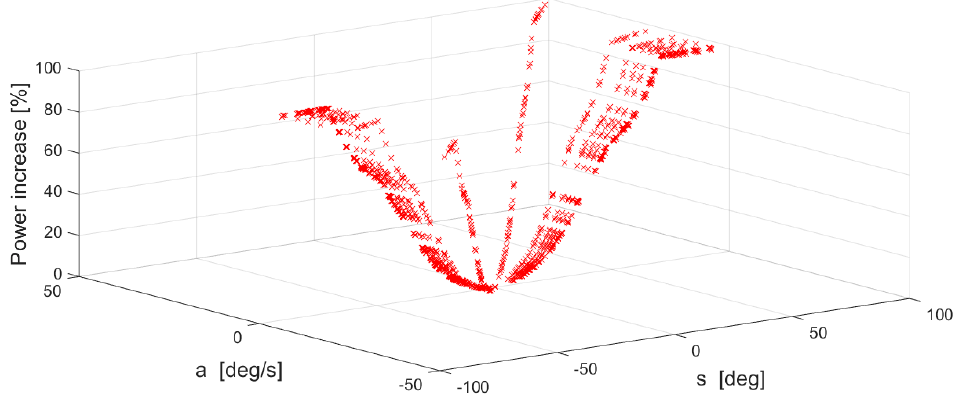
Figure 13. Graphical representation of the Q(s,a) matrix.